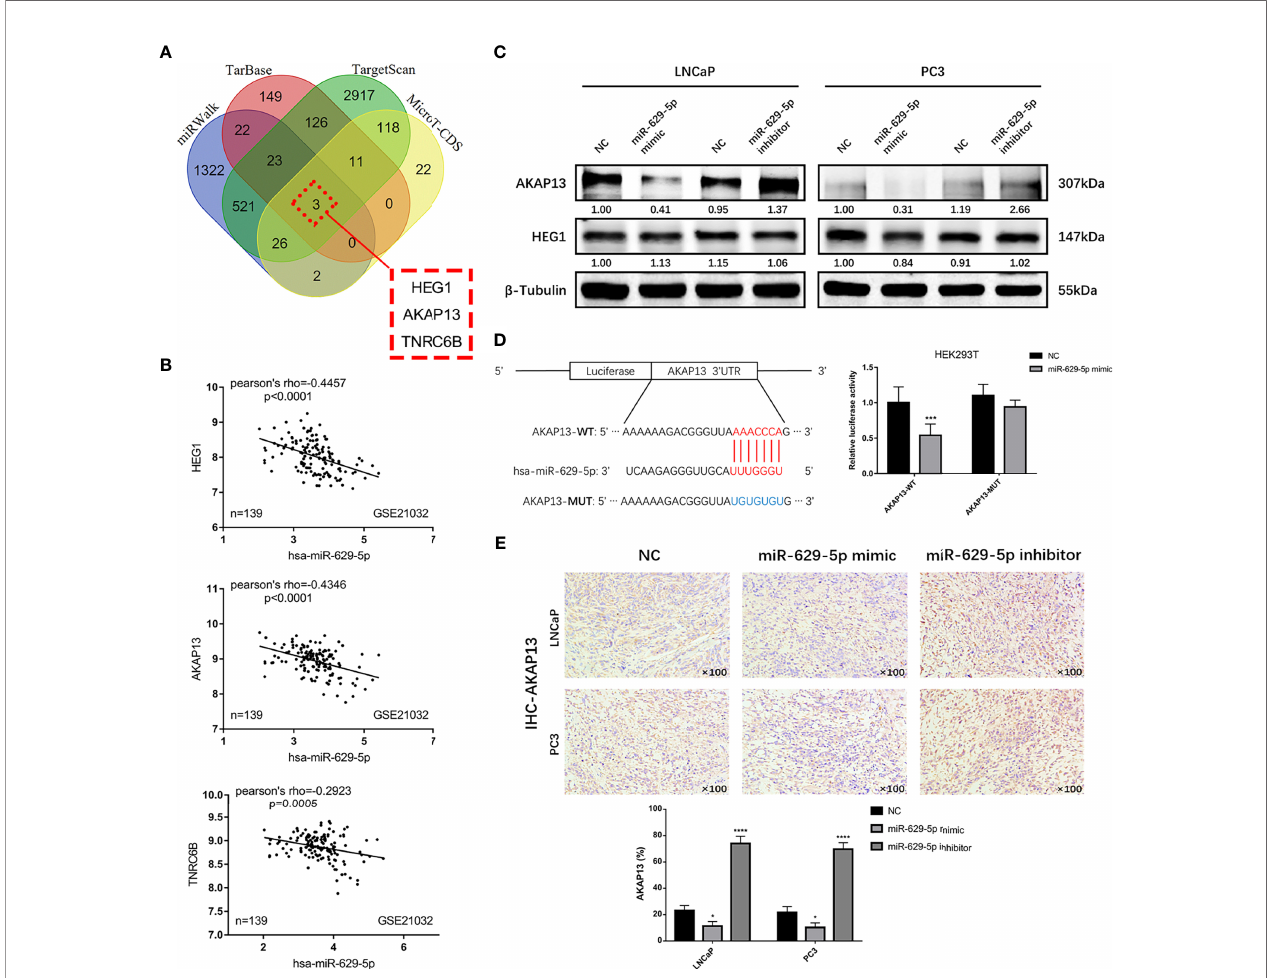
FIGURE 4 | AKAP13 is a direct function target of miR-629-5p. (A) Identify potential miR-629-5p target genes by four common miRNA prediction tools. (B) The correlations between miR-629-5p expression and HEG1, AKAP13 and TNRC6B expression in GSE21032. (C) Western blotting was carried out to verify the expression of HEG1 and AKAP13 at protein level in stable transfected PCa cells, merely AKAP13 could be signi fi cantly regulated by miR-629-5p, but not HEG1. (D) Left: potential miR-629-5p binding sites in the 3 ’ UTR of AKAP13 mRNAs. Right: the dual-luciferase reporter assays showed that miR-629-5p overexpression signi fi cantly reduced the luciferase activity of binding site of AKAP13, and the mutation of binding site blocked the interaction. (E) AKAP13 IHC staining was performed in xenograft tumor tissues. Magni fi cation, ×100. The data were presented as means ± SD from three biological replicates. *P < 0.05; ***P < 0.001; ****P < 0.0001; Student ’ s t-test. WT, wide type; MUT,